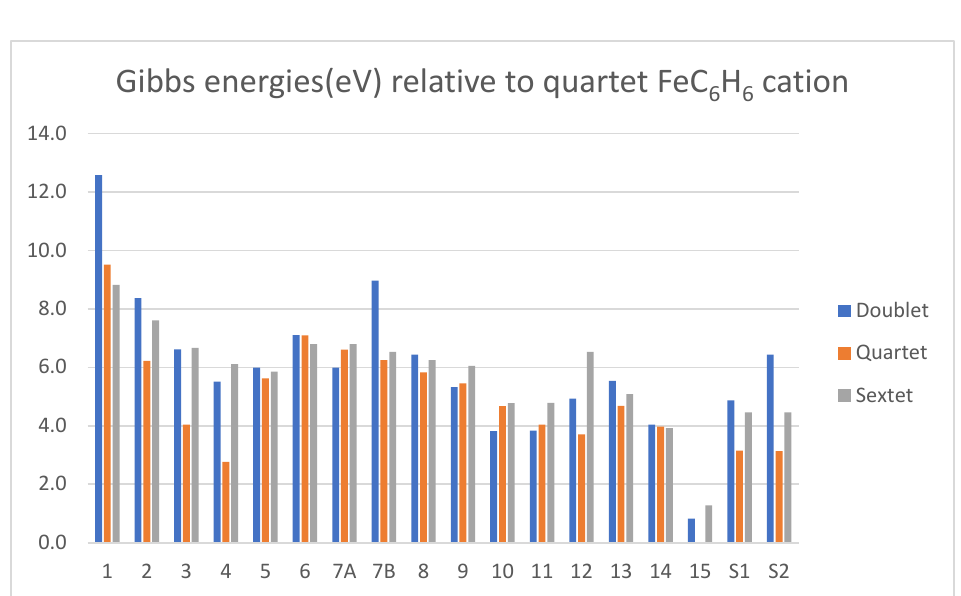
Figure 2. Gibbs Energy profile for landmark structures for the C 2n H 2n -Fe(+) system. The Gibbs energy is composed of (a) the electronic energy E D computed in the ω B97XD/def2-tzvp model; (b) Z which is the zero-point vibrational energy; (c) a thermal correction representing the integral of the ideal gas constant-pressure heat capacity, C p = 5R/2, integrated from lower bound 0 to the standard temperature T ; and (d) the entropy term. S is composed of several parts, including a vibrational portion which can be evalu- ated by use of the vibrational partition function, a spin multiplicity contribution of form k ln(W) for which W is the spin multiplicity, and a translational portion which can be eval- uated by the Sackur Tetrode equation, applicable for an ideal gas composed of particles of mass m . All these terms are computed within the Gaussian software [22,23].